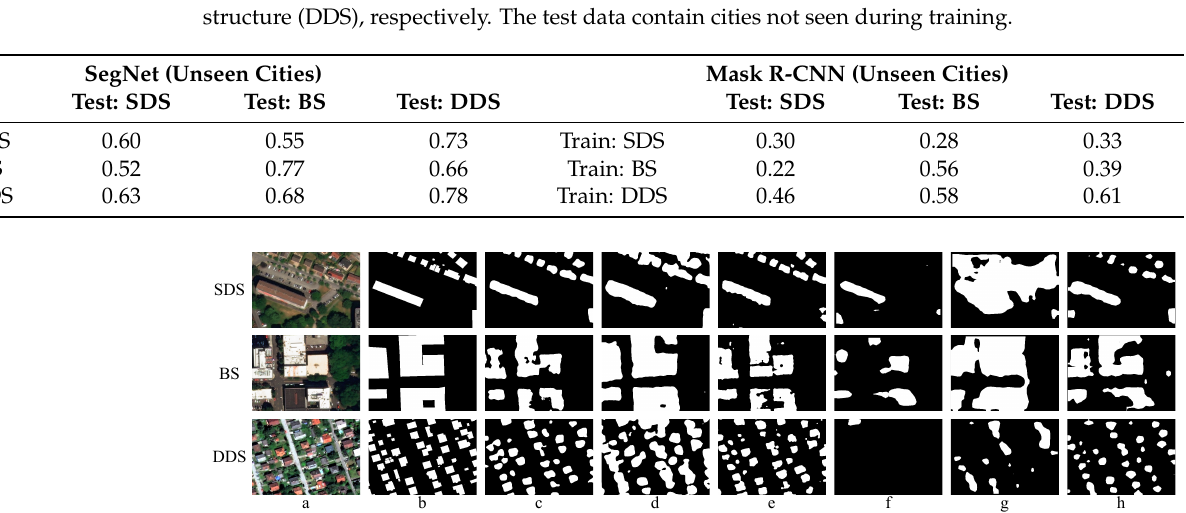
Figure 12. Robustness to different building density (RQ6): three example images from the test sets of GDBX SDS , GDBX BS , and GDBX DDS , together with the predicted masks by the models: ( a ) input image; ( b ) ground truth; ( c ) SegNet trained on SDS; ( d ) SegNet trained on BS; ( e ) SegNet trained on DDS; ( f ) Mask R-CNN trained on SDS; ( g ) Mask R-CNN trained on BS; ( h ) Mask R-CNN trained on